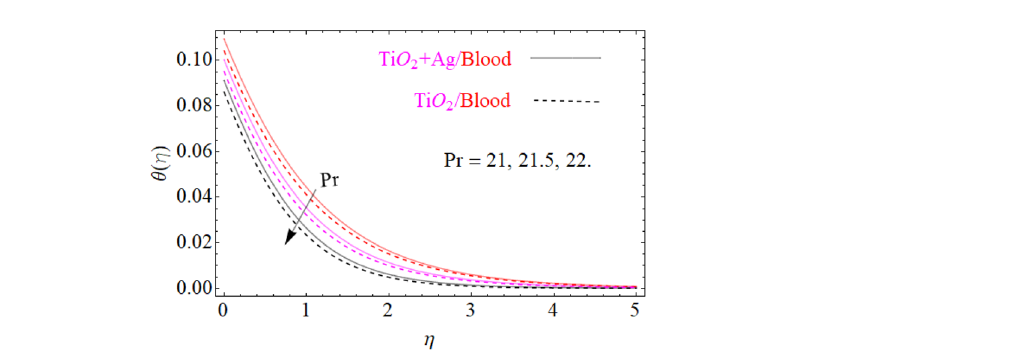
Figure 9. Under the influence of Pr (Prandtl number), θ(η) .